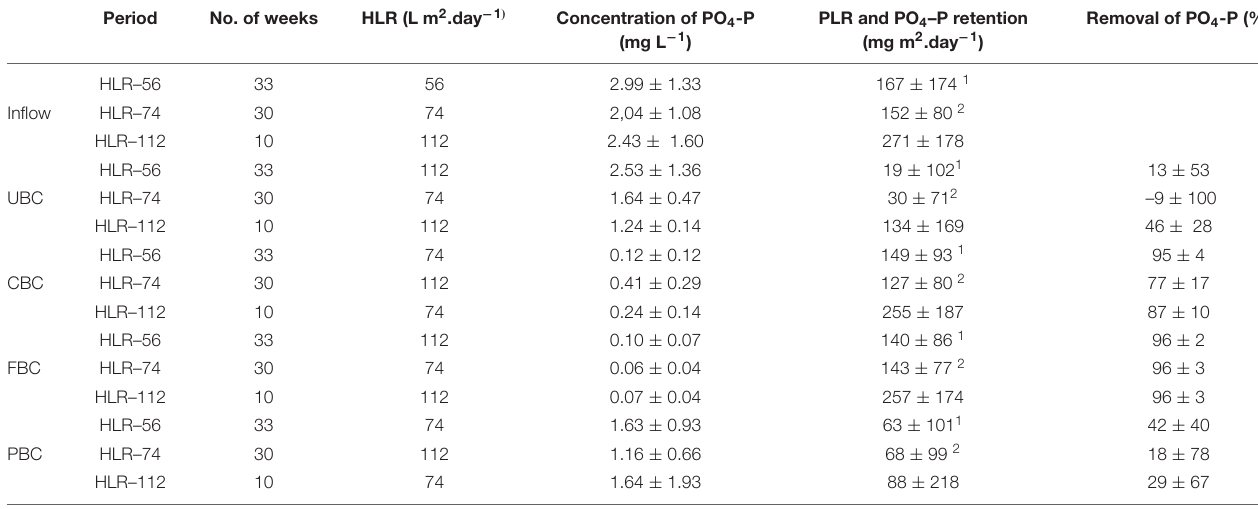
PLR, phosphorus loading rate. 1 This loading period included the start-up and restart of the filter after reaching stable state. 2 Average loading conditions during the periods HLR74-1 and